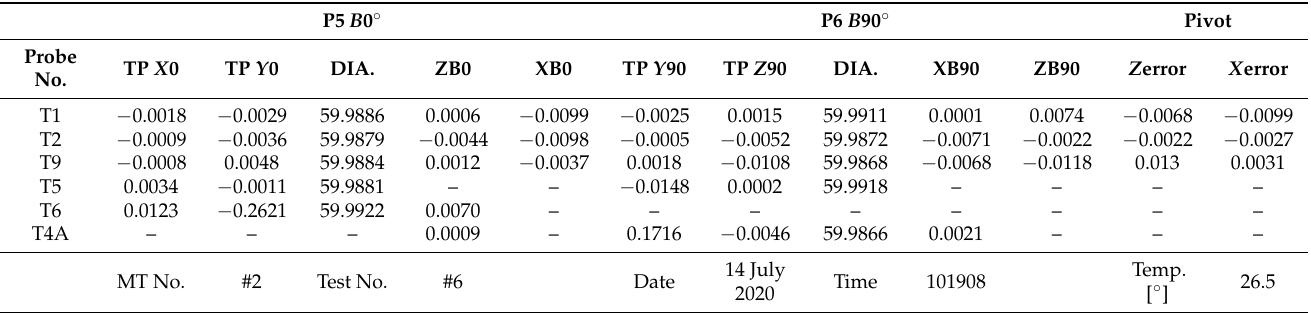
Table 6. Example of collected test data from one set of measurements, all types of